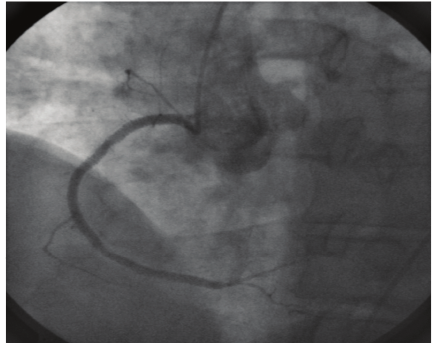
Figure 3: ECG after the index PCI revealed increased transient ST- elevation in the anteroseptal leads V2–V5.